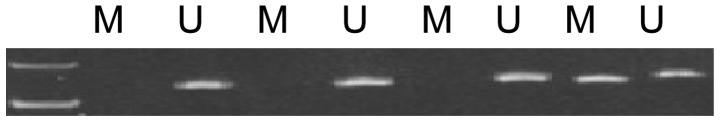
Representative results of methylation-specific PCR analysis of GSTP1 in breast cancer patients. Amplification in M lane represents methylation, amplification in U lane represents unmethylation, and amplification in M and U lanes represents hemimethylation. M, methylated; U, unmethylated.